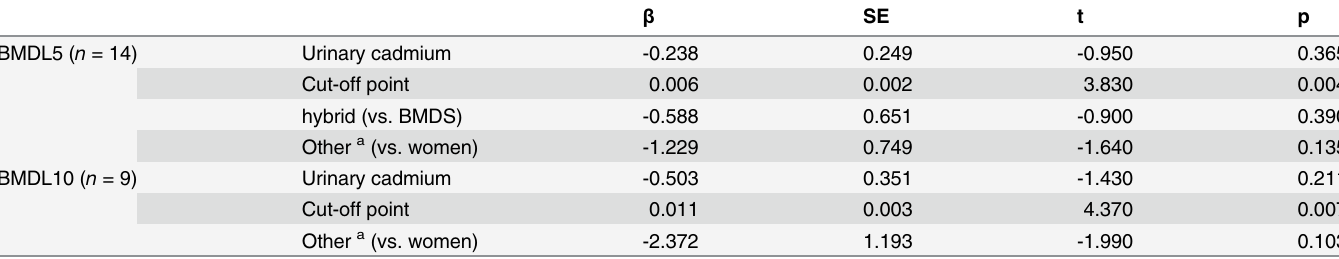
Table 3. Meta-regression analysis for BMDL5 and BMDL10 derived from urinary cadmium and β 2-MG.